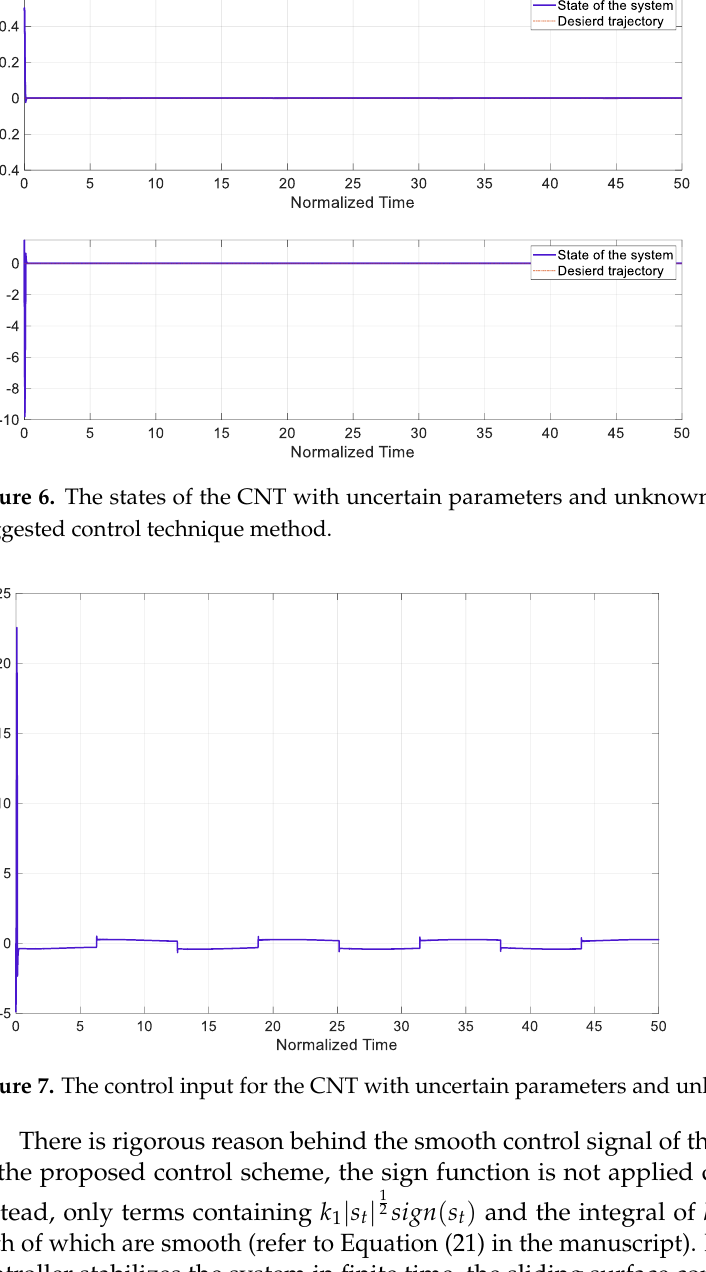
Figure 8. The states of CNT in tracking control in the presence of uncertain parameters and un- known disturbance.